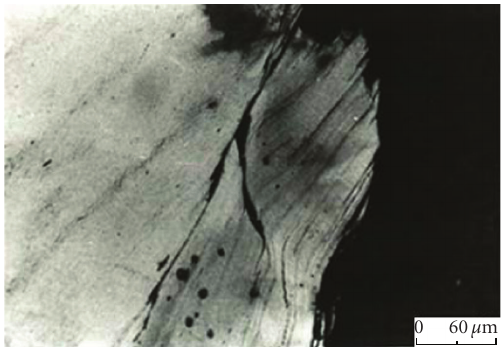
Figure 5: Optical metallograph of vertical section after impact- corrosion wear for 8 hours and 16 hours at the impact energy of 1.2J.